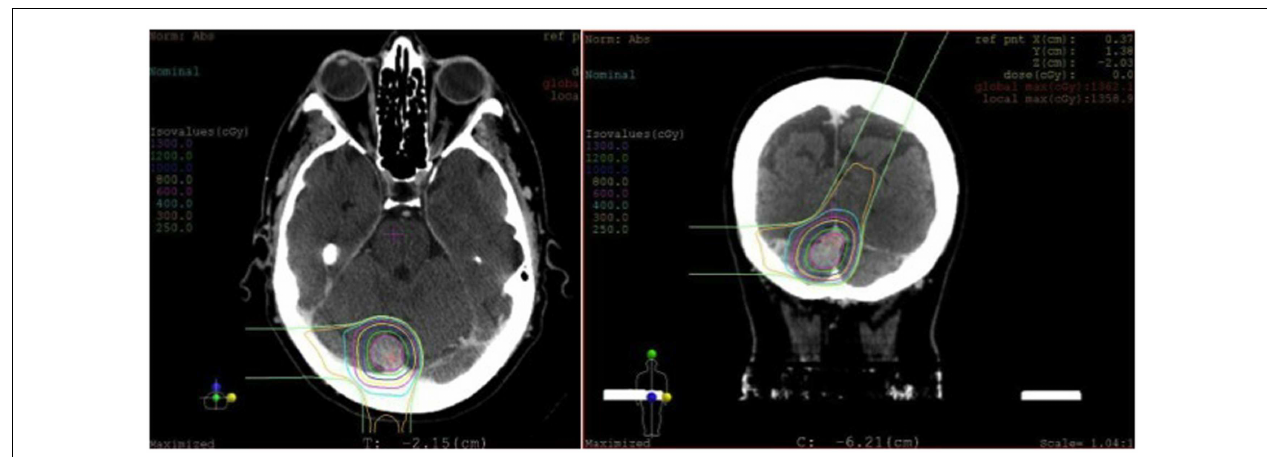
FIGURE 6 | Radiosurgery dosimetry . Dosimetry map for proton radiosurgical treatment of a torcular meningioma.